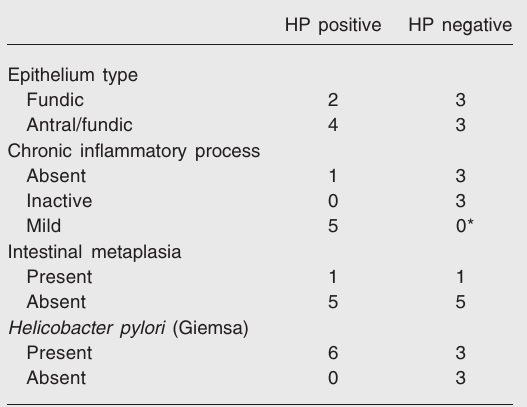
Table 2. Characteristics of ectopic gastric mucosa associ- ated with Helicobacter pylori (HP) infection in 12